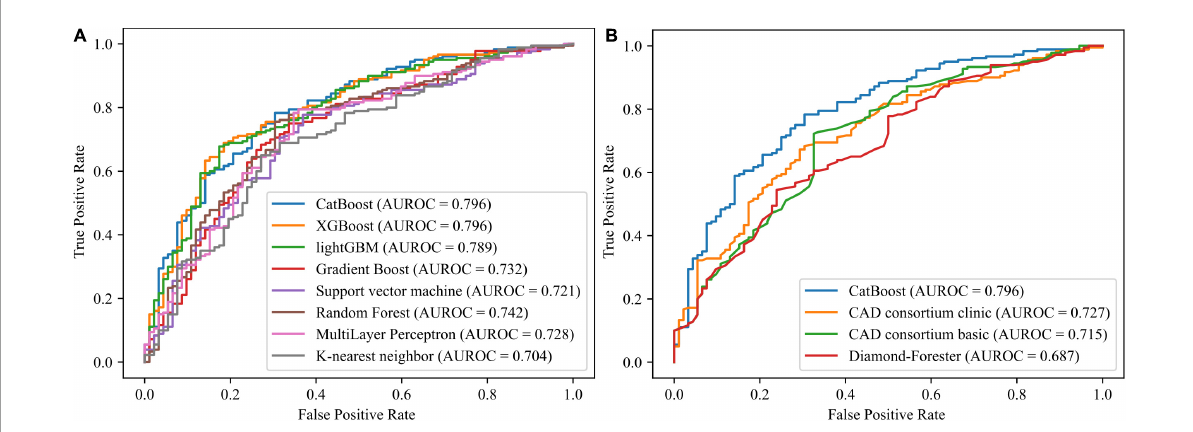
FIGURE2 Receiver operating characteristic curves for the machine learning models and established pre-test probability of CAD models. (A) Comparing the eight machine learning models. (B) Comparing the CatBoost model and the established pre-test probability of CAD models. AUROC, area under the receiver operating characteristics; CAD, coronary artery disease; GBM, gradient boosting machine; XG, extreme